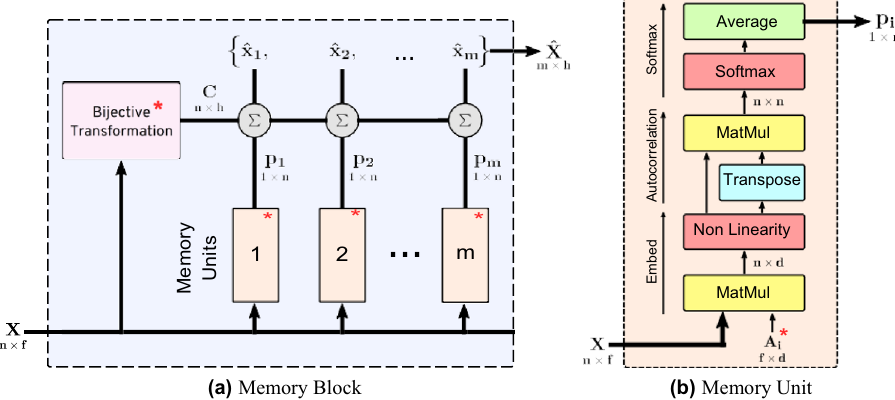
Figure 3. Schematic of a MEM model used for the classification of WSI mosaics. X is an input sequence containing a number n of f -dimensional vectors. ( a ) The memory block is a sequence-to-sequence model ˆ X ˆ X that takes X and returns another sequence . The output is a permutation-invariant representation of X . A bijective transformation model (an autoencoder) converts the input X to a permutation-equivariant sequence C . The weighted sum of C is computed over different probability distributions p i from memory units. The hyper- parameters of a memory block are (1) the dimensions of the bijective transformation h , and (2) the number of memory units m . ( b ) The memory unit has A i , a trainable embedding matrix that transforms elements of X to a d -dimensional space (memories). The output p i is a probability distribution over the input X , also known as attention. The memory unit has a single hyper-parameter d , i.e. the dimension of the embedding space 33 (* represents learnable